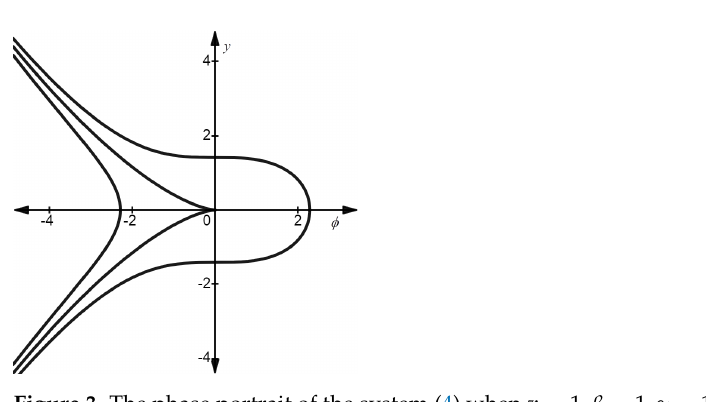
Figure 2. The phase portraits of the system (4) when ( v − 1 )( β + γ v ) > 0.